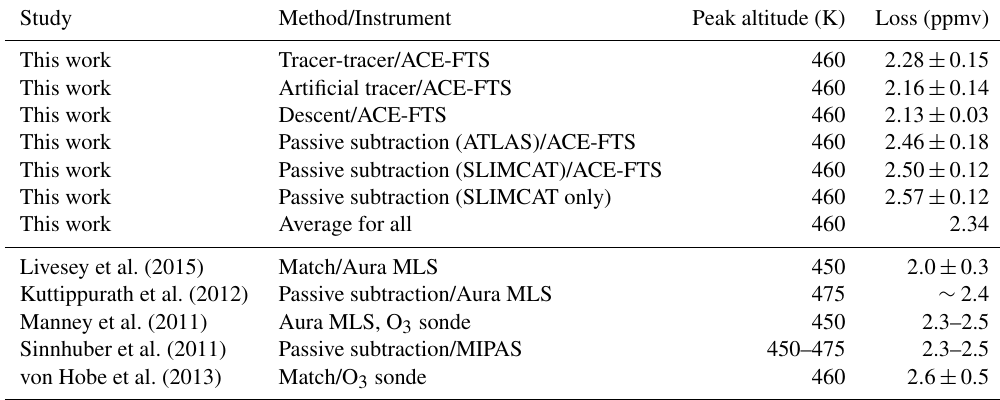
Table 2. Estimates of the peak altitude and maximum ozone loss observed during the 2010–2011 Arctic winter.